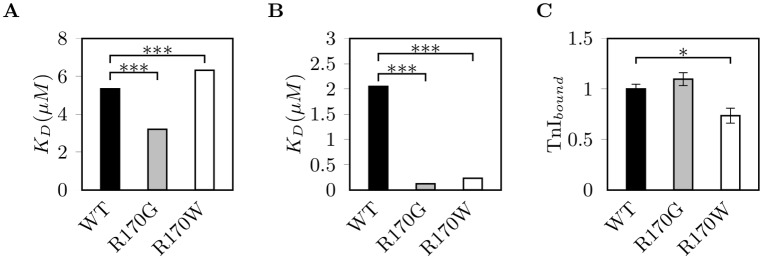
Interactions of cTn with actin, tropomyosin and reconstituted thin filaments.Binding kinetics of cTn containing cTnI-R170G/W (gray or white, respectively) or wildtype (WT, black) to immobilized (A) actin and (B) tropomyosin measured by SPR. Dissociation constants are given as KD ±SEM (n = 3). (C) Binding of troponin containing cTnI-variants to F-actin decorated with tropomyosin analyzed by cosedimentation. Data given as amount of bound cTnI relative to total cTnI in the sample ±SEM (n = 20). * indicates statistical significance with P<0.05; *** indicates statistical significance with P<0.001.